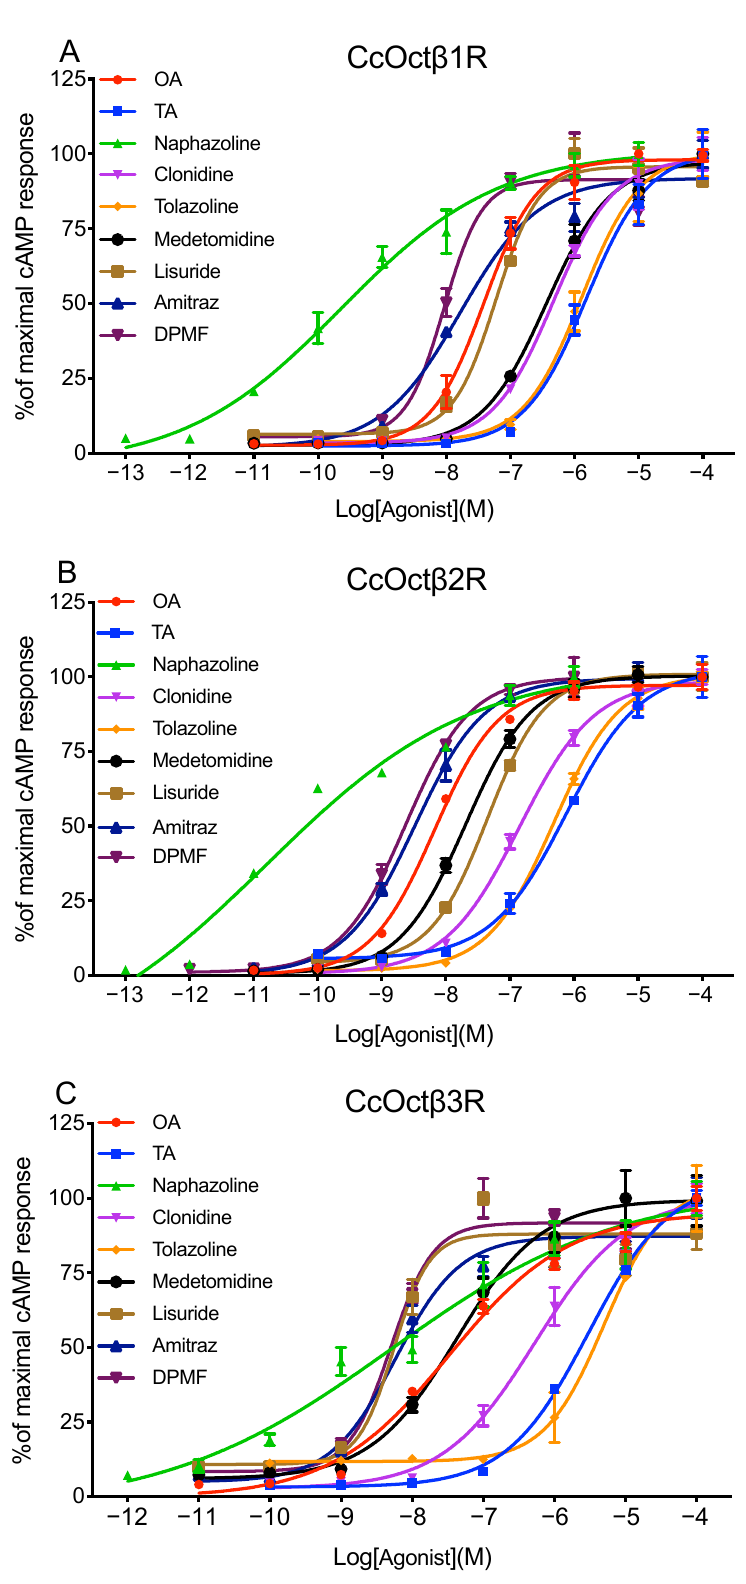
Figure 4. Concentration-response effects of OA, TA and various agonists on intracellular cAMP production in CcOct β 1R ( A )-, CcOct β 2R ( B )-, and CcOct β 3R ( C )-expressing CHO-K1 cells. The values are calculated to the maximal cAMP response (=100%) for each agonist. Data are presented as means ± SE of four